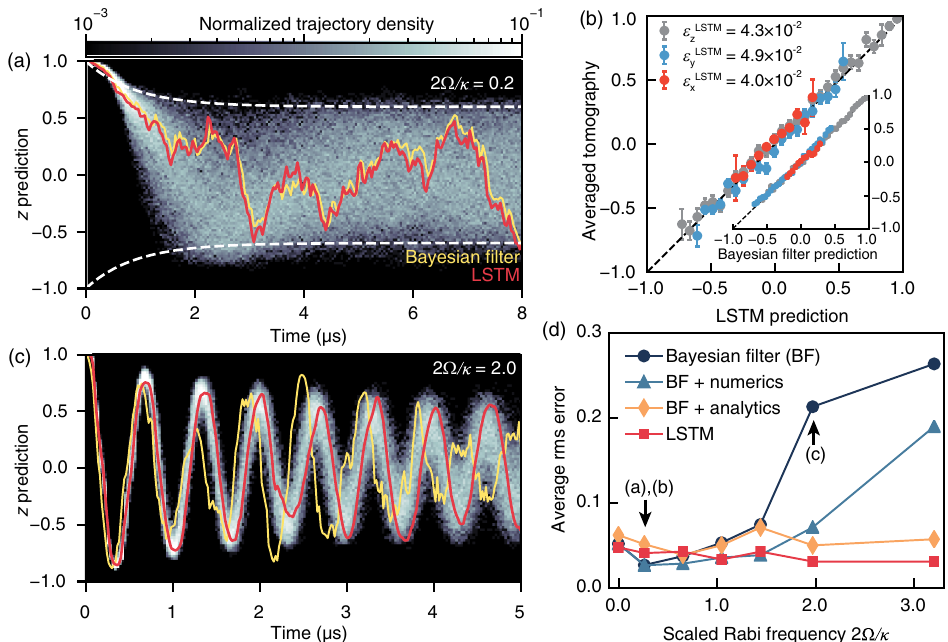
8 . 0 μ s FIG. 2. Breakdown of adiabatic trajectory reconstruction. (a) The histogram of weakly driven trajectories of length T m ¼ (reconstructed by the LSTM with dt ¼ 40 ns) shows rapid trajectory diffusion due to measurement backaction. The color bar represents the trajectory probability density at each time step. The LSTM produces trajectories (example in red) comparable to those from a steady- state Bayesian filter (yellow). (b) LSTM validation based on tomographic measurements immediately following the LSTM prediction, for the trajectories shown in (a) where 2 Ω = κ ¼ 0 . 2 . The dashed line with slope 1 indicates perfect validation. The inset shows the 2 . 3 ; 3 . 2 ; 2 . 5 Þ × 10 − 2 . This is partly ; ε BF ; ε BF Bayesian filter validation for the same dataset with slightly smaller rms error ð ε BF x y z Þ ¼ ð are computed using the entire dataset, whereas ε LSTM only have access to trajectories not used for training. (c) For fast because ε BF x;y;z x;y;z qubit dynamics ( 2 Ω = κ ¼ 2 . 0 ) outside the adiabatic regime the predictions of the steady-state Bayesian filter and LSTM diverge (trajectory dt ¼ 20 ns). (d) Validation errors averaged over the three qubit coordinates versus Rabi frequency 2 Ω = κ , showing a breakdown of the steady-state Bayesian filter for 2 Ω = κ > 1 (dots, BF), while the LSTM validation error (squares) remains small. The performance of the Bayesian filter improves with additional numerical prior information of the expected evolution of the z -conditioned resonator fields (BF þ numerics; see Appendix G), and improves even further when adding analytical corrections to the measurement backaction (BF þ analytics; see Appendix K). Importantly, the LSTM performance stays consistent without additional prior information. Arrows mark the data shown in (a) –